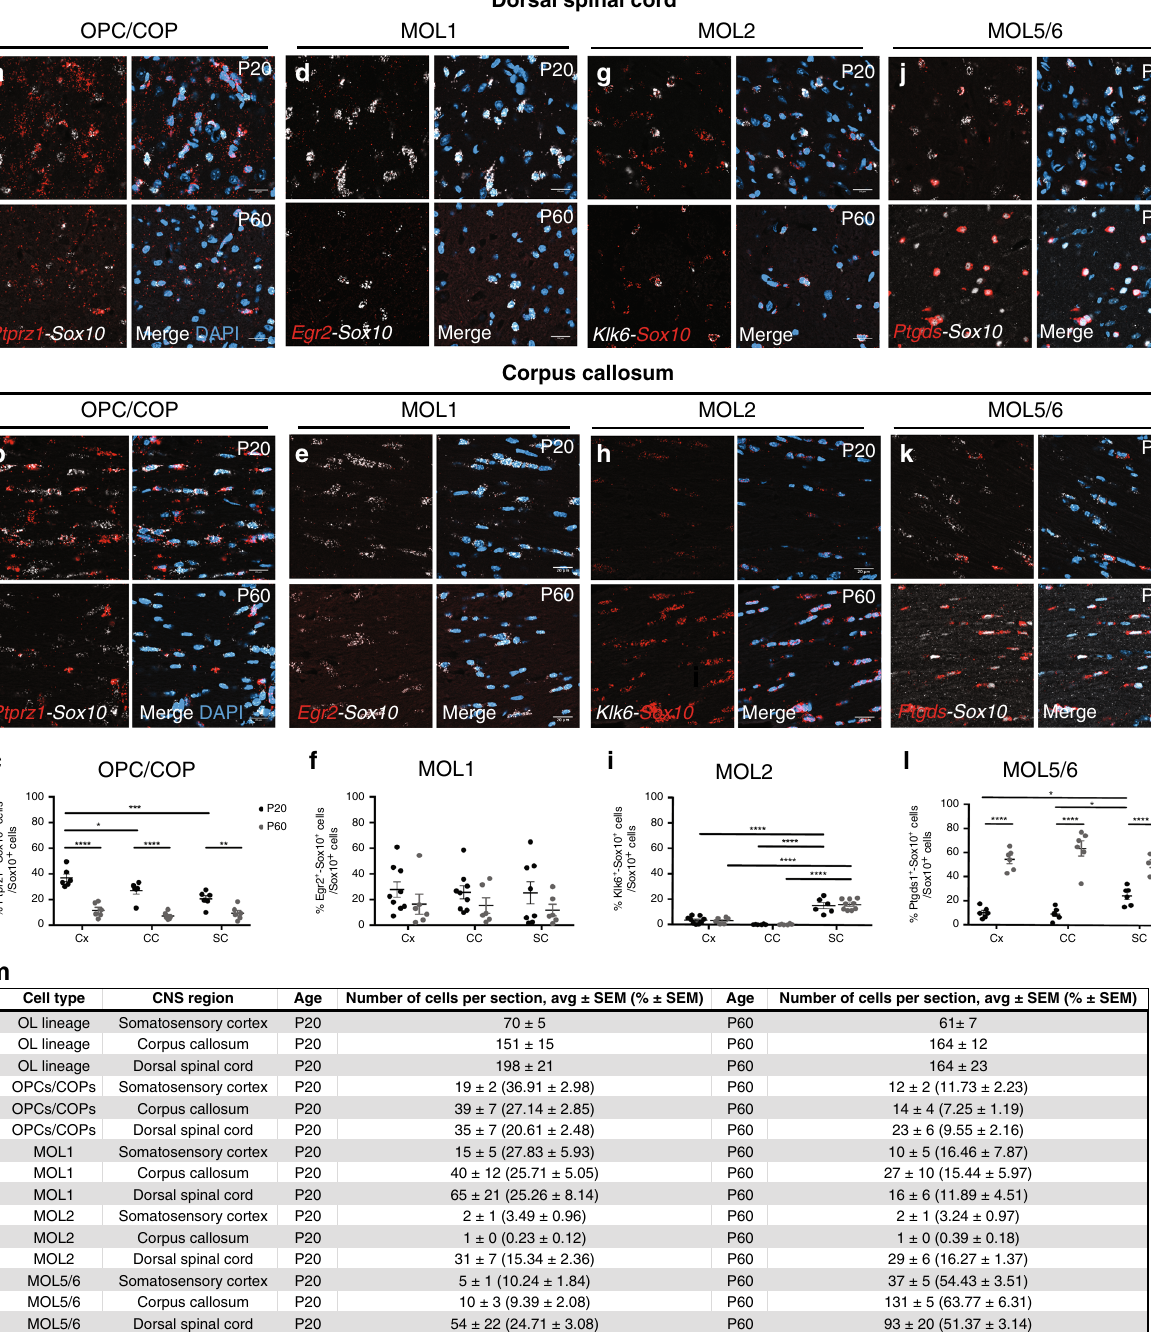
Fig. 1 Speci fi c mature OL populations have spatial preference in the juvenile and adult central nervous system. a – k Confocal representative images of the distribution of OPC/COP ( Ptprz1 + OL lineage cells, a and b ), MOL1 ( Egr2 + OL lineage cells, d and e ), MOL2 ( Klk6 + OL lineage cells, g and h ), and MOL5/6 ( Ptgds + OL lineage cells, j and k ) in the juvenile (P20) and adult (P60) dorsal spinal cord (dorsal horn gray matter, a , d , g , j ) and corpus callosum ( b , e , h , k ). Scale bar = 20 μ m. c , f , i , l Quanti fi cation of the OPC/COP ( c ), MOL1 ( f ), MOL2 ( i ), MOL5/6 ( l ) distribution in the cortex, corpus callosum, and dorsal spinal cord (dorsal horn and dorsal white matter) in juvenile (P20) and adulthood (P60). Percentage of the population is calculated on the total number of OL lineage cells (Sox10 + cells) in the analyzed region. Data are presented as mean±SEM. n = 6 animals per condition, and can be assessed in the Source Data fi le. Black circles — P20; Gray circles — P60; Asterisks indicate a signi fi cant difference between conditions (* p ≤ 0.05, ** p ≤ 0.01, *** p ≤ 0.001, **** p ≤ 0.0001, two-way ANOVA with Sidak ’ s correction). Exact p values are reported in the Source Data fi le. m Quanti fi cation of the OL subpopulations contribution to the OL lineage. Average number and percentage of the OL lineage cells ( Sox10 + ), OPC-COPs ( Ptprz1 + OL lineage cells), MOL1 ( Egr2 + OL lineage cells), MOL2 ( Klk6 + OL lineage cells), and MOL5/6 ( Ptgds + OL lineage cells) contribution to the OL lineage ( Sox10 + cells) in the regions of interest in juvenile (postnatal day (P) 20) and adulthood (P60). We imaged 0.3, 0.13, and 0.4mm 2 of the sensorimotor cortex, corpus callosum, and dorsal spinal cord per tissue section, respectively. Minimum three sections per animal were analyzed. Data are presented as mean±SEM. n = 4 − 9 animals per condition, and can be assessed in the Supplementary Source Data fi le. Blue staining in merged images correspond to 4 ′ ,6-diamidino-2-phenylindole (DAPI) staining. Cx cortex, CC corpus callosum, SC spinal cord. OPC oligodendrocyte progenitor cell, COP committed OPC, MOL mature oligodendrocyte. Source data are provided as a Source Data fi